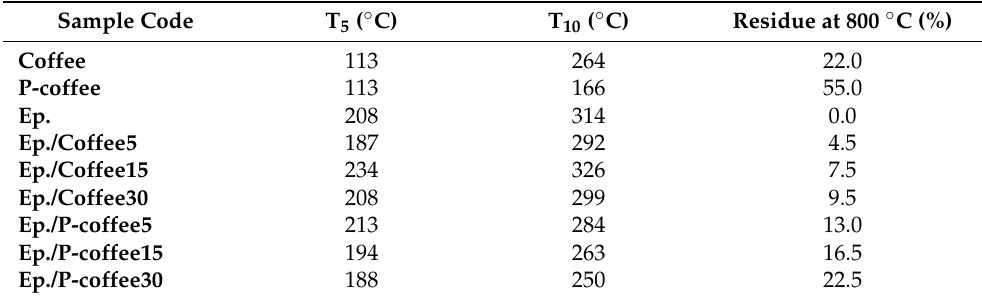
Figure 7. TGA thermograms of epoxy and epoxy composites containing various amounts of unmodified coffee biowaste (Coffee); ( a ) those of coffee biowaste modified with phosphorus (P-coffee) ( b ). Table 3. Thermal decomposition characteristics of neat epoxy and epoxy composites extracted from TGA diagrams.